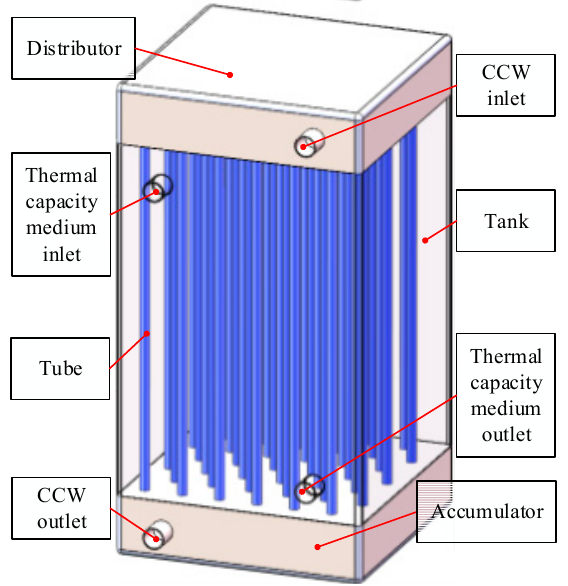
Figure 3. Three-dimensional structure of the tube-tank heat exchanger.